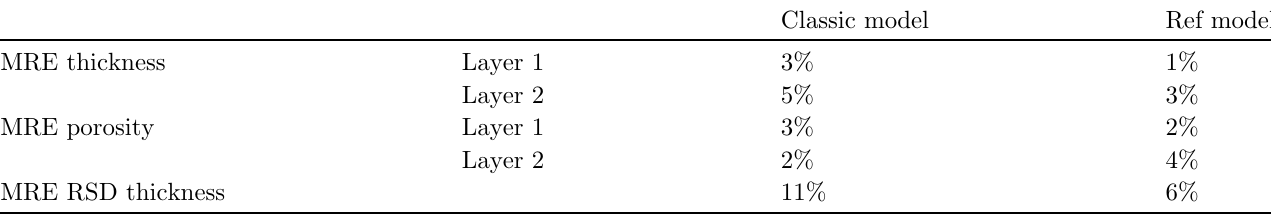
curve.Theinformationoftheconsistencylossisnotsuf fi cient